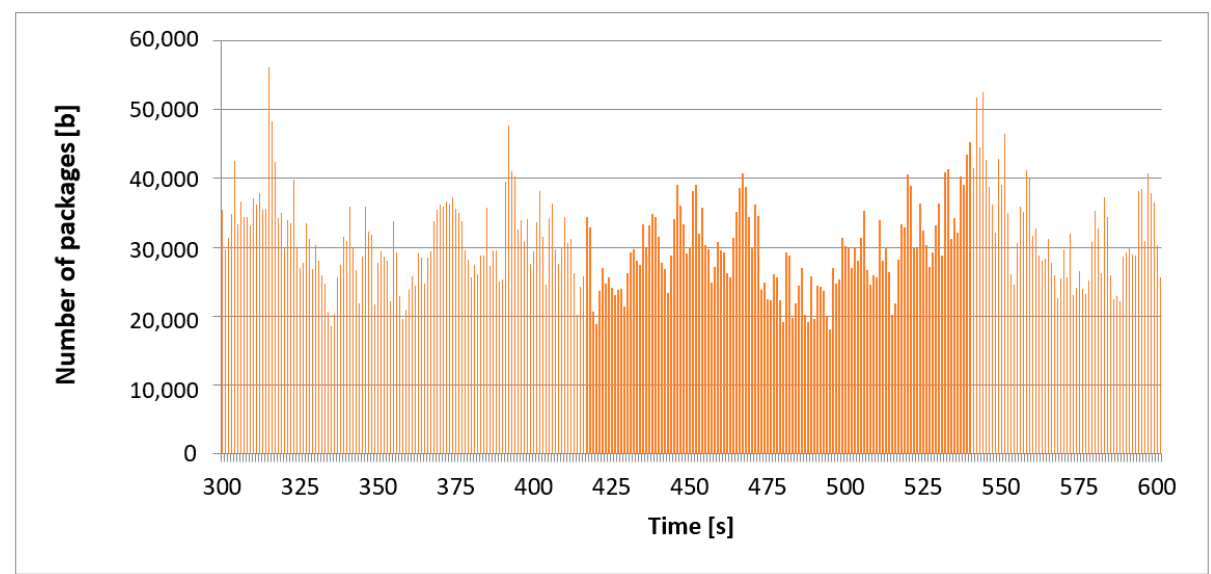
Figure 3. Overall network traffic over 300 s.